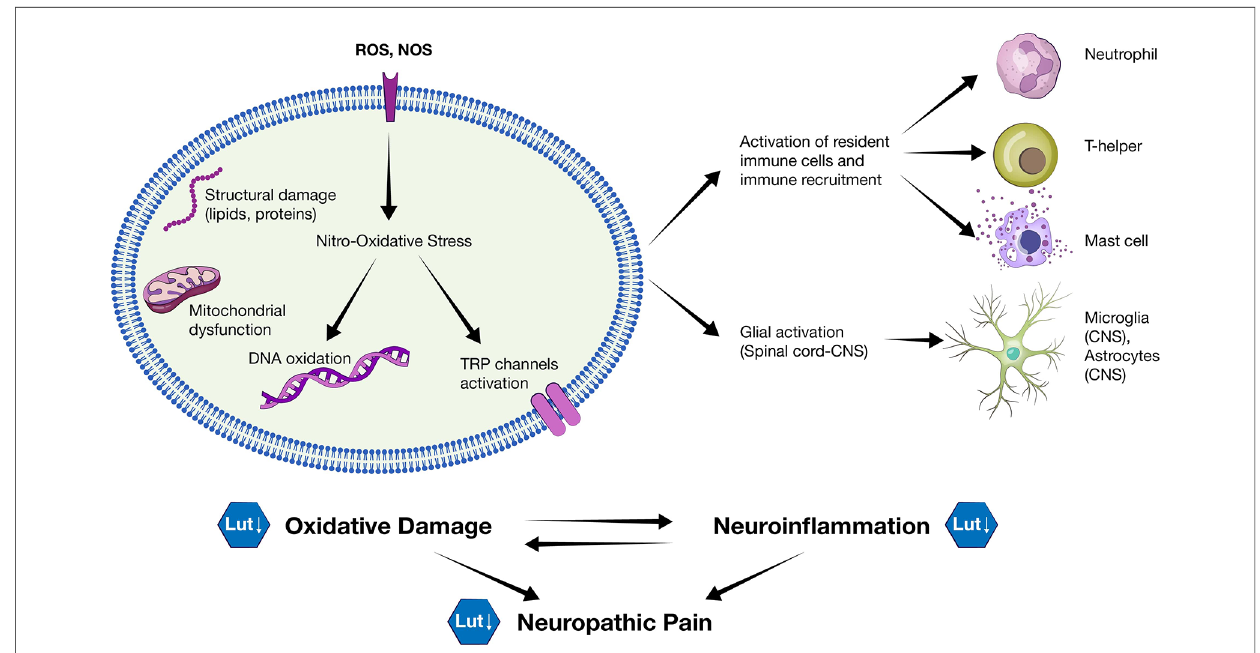
FIGURE 6 Oxidative damage and neuroin fl ammation in neuropathy. An illustration of the pathogenetic mechanisms implicated in neuropathic pain. ROS and NOS can induce nitro-oxidative damage in the vulnerable neuronal cells and activation of TRP channels which are involved in neuropathic pain transduction. Neuroin fl ammation - induced from neuronal cell damage - involves the activation of resident immune cells and glial activation. Oxidative damage and neuroin fl ammation, which are considered to be reciprocal processes, can be inhibited by